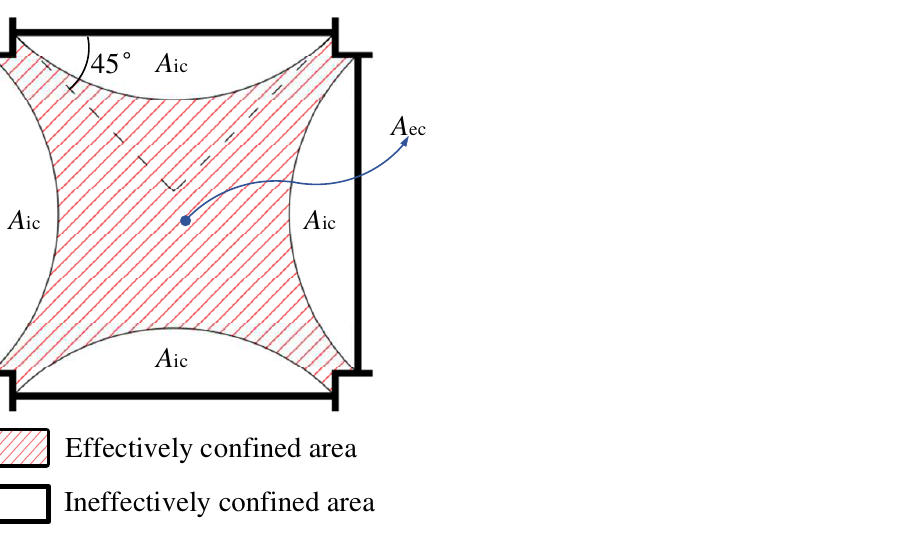
Figure 16. Division of effectively and ineffectively areas.